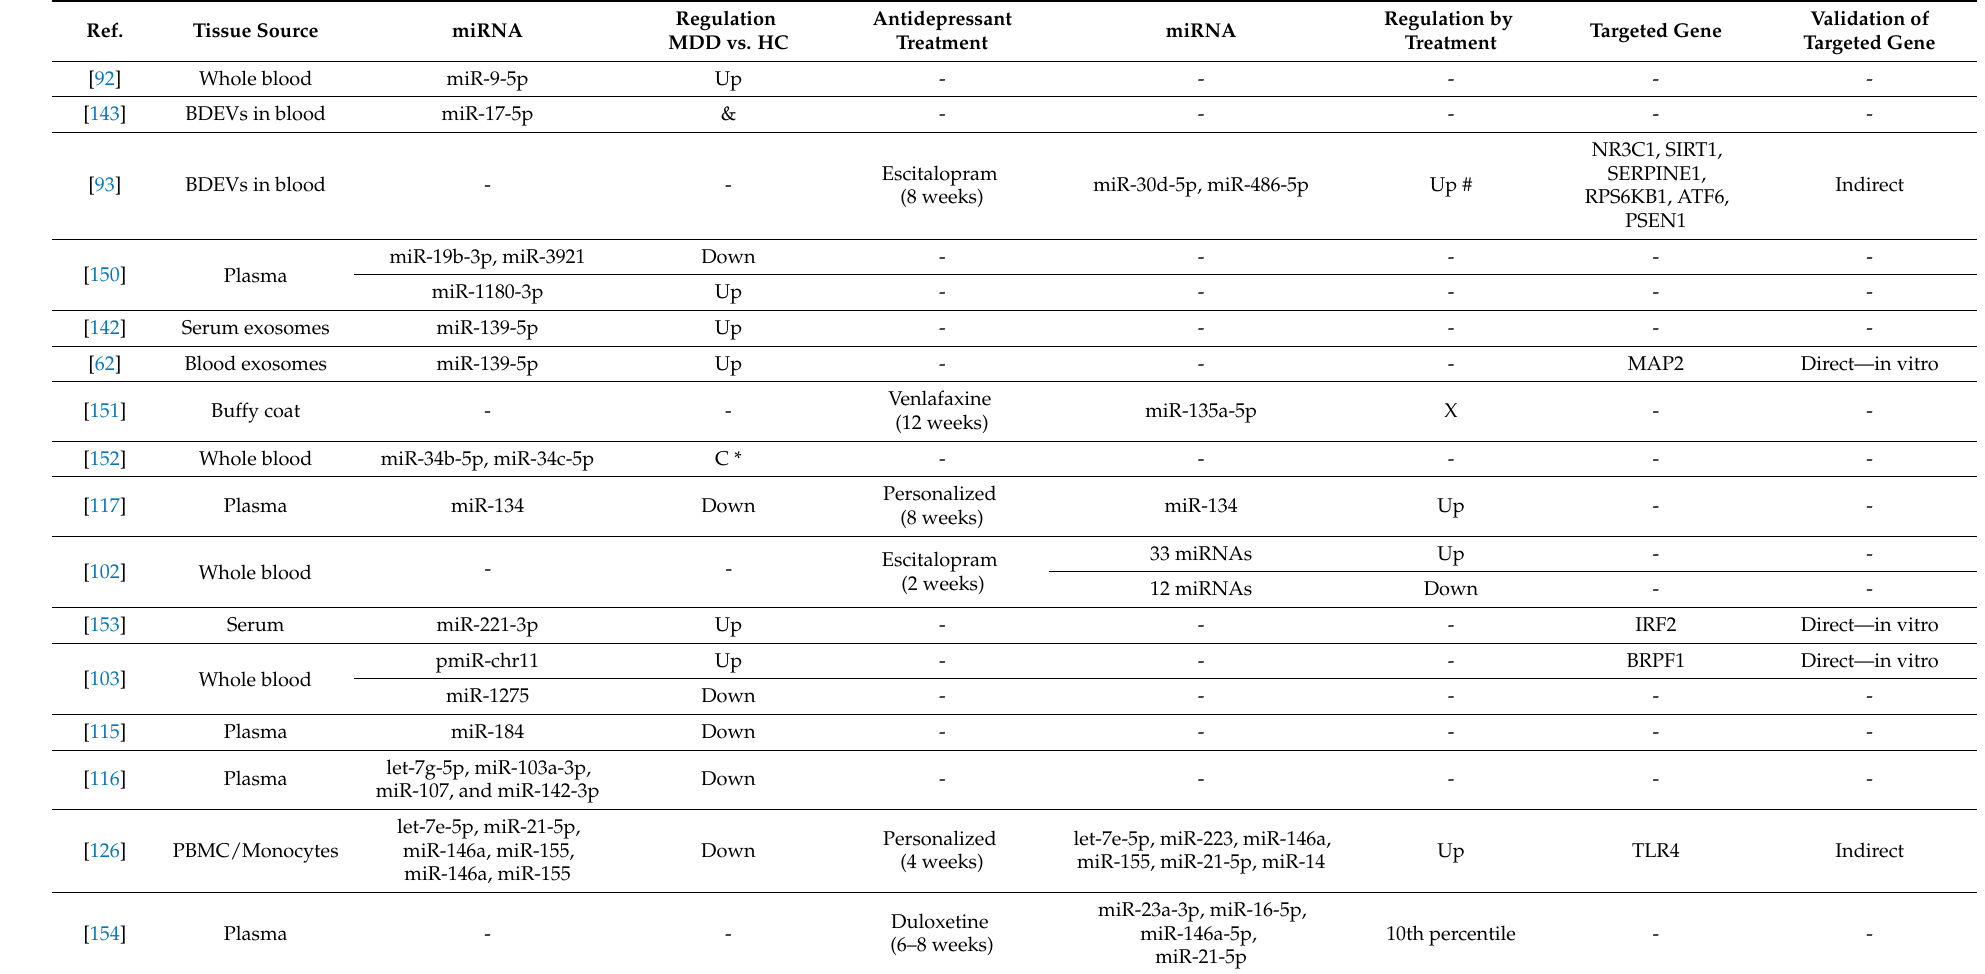
Table 2. List of studies comparing peripheral miRNA expression data in depression and antidepressant treatment.